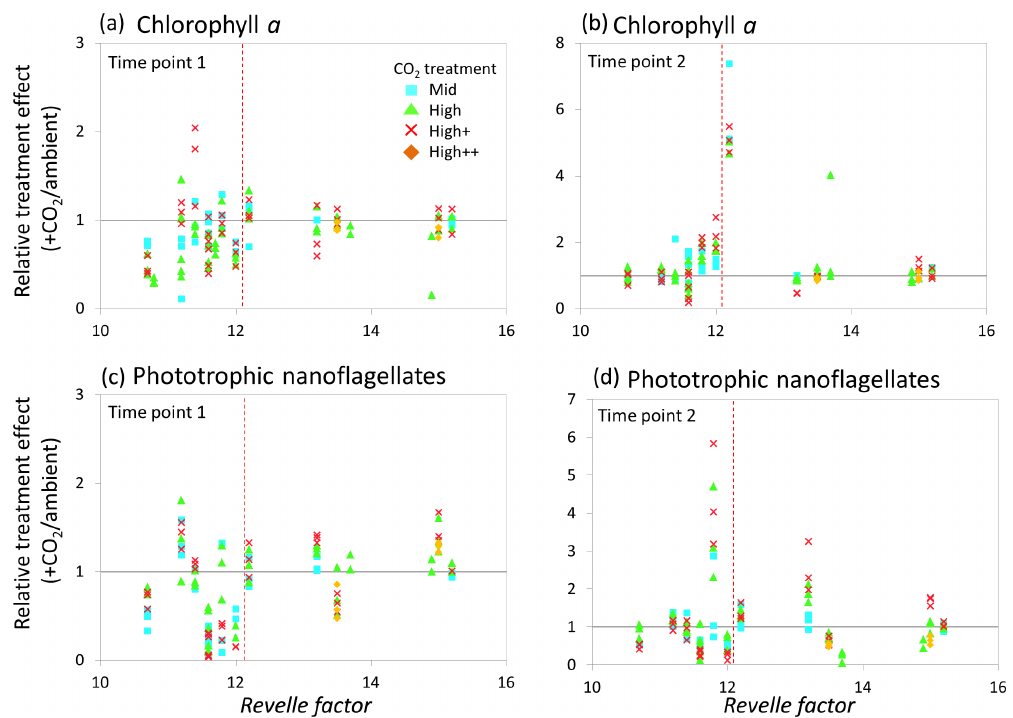
/ [ x ] ambientCO ) 2 2